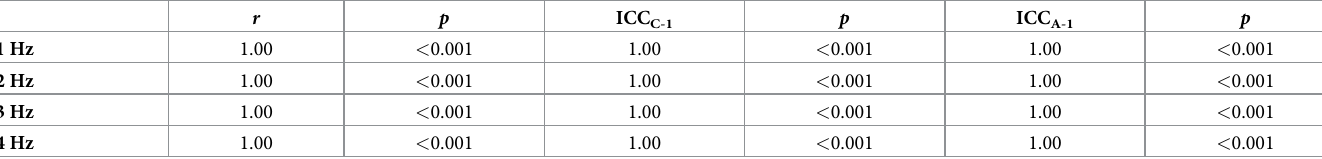
Table 1. Statistical results for correlational analyses of pose estimation vs. manual identification of finger tapping.